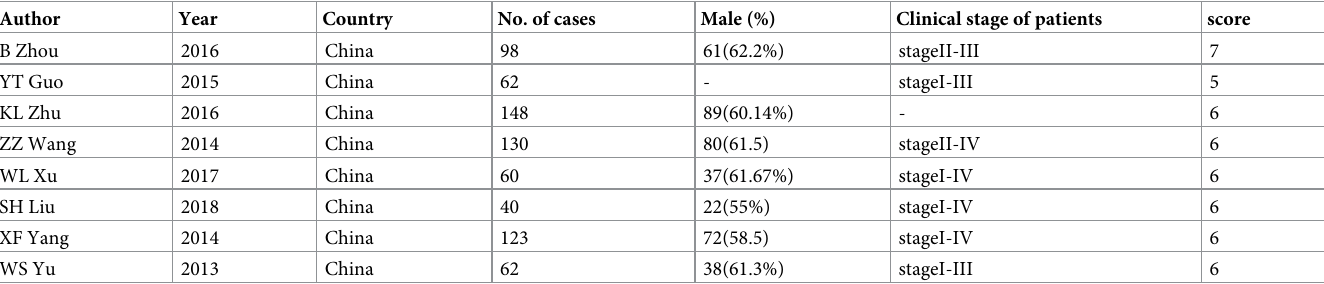
tion) (OR = 0.56, 95%CI = 0.30–1.06, P = 0.076) (Fig 3D); lymphatic metastasis (with lym- phatic metastasis vs. without lymphatic metastasis) (OR = 1.27, 95%CI = 0.92–1.76, P = 0.152) (Fig 3E); tumor size ( < cut-off vs � cut-off) (OR = 1.27, 95%CI = 0.86–1.88, P = 0.229) (Fig 3F); and T stage (T1/2 vs T3/4) (OR = 0.70, 95%CI = 0.43–1.13, P = 0.141) (Fig 3G). Table 1. Baseline characteristics of included